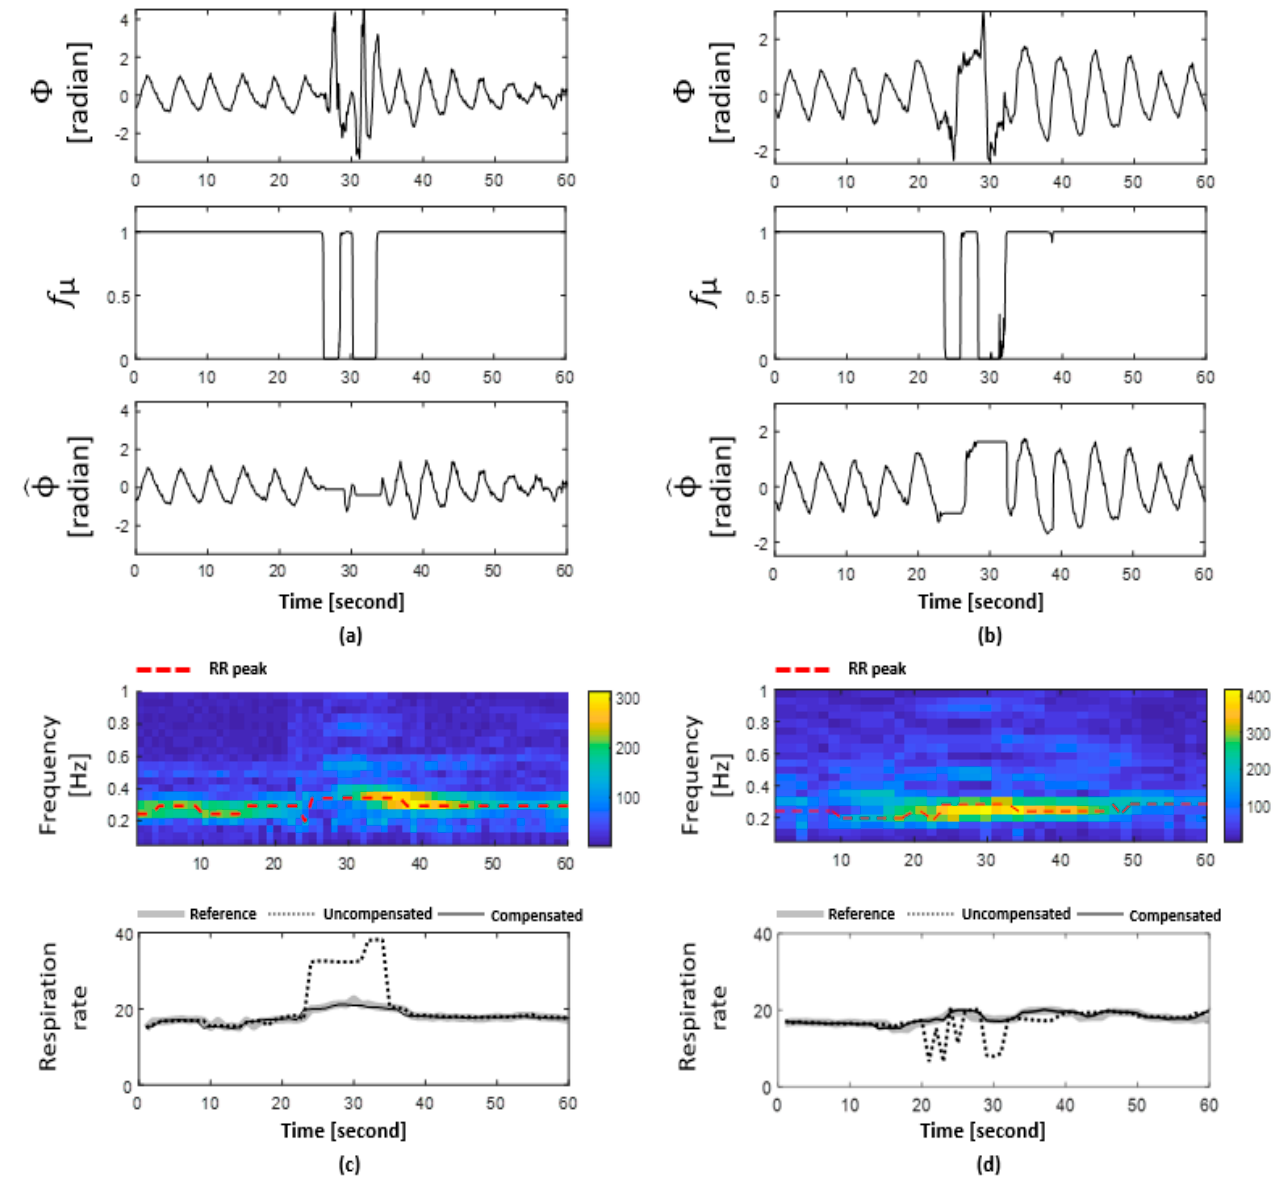
Figure 9. Compensated respiration rate estimation and comparison in each situation where the driver ’ s movement is present. ( a , c ) Respiration compensation in turn left, ( b , d ) respiration compen- sation in turn right .